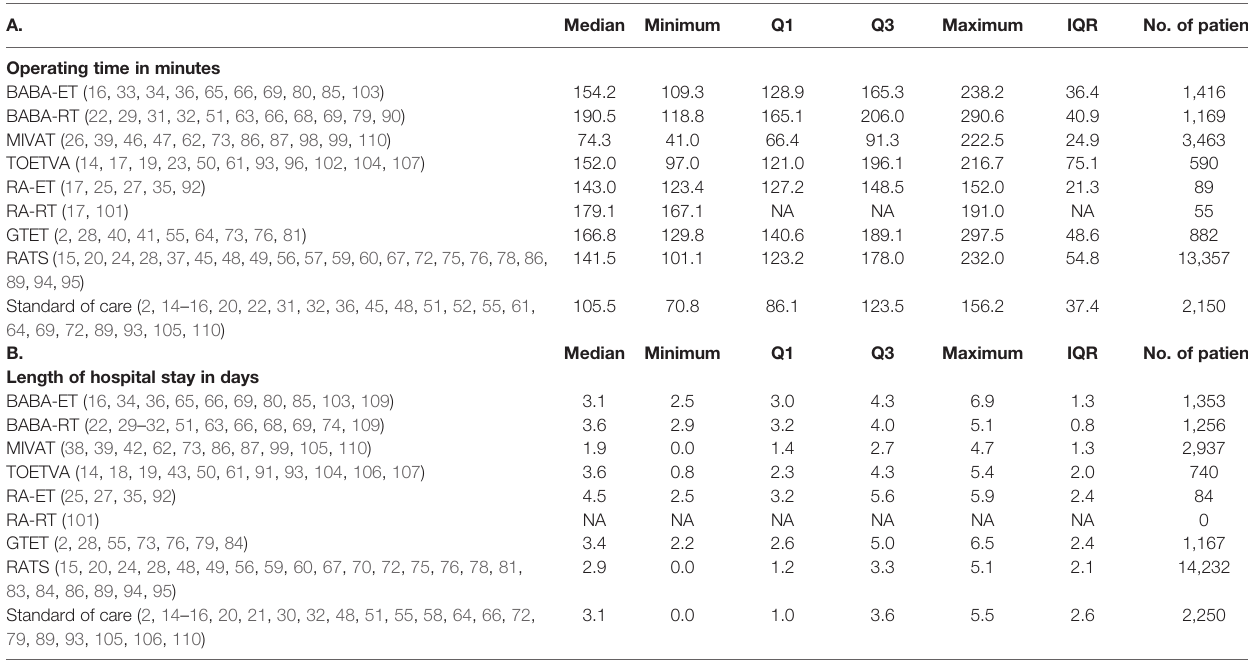
TABLE 1 | Operating time and length of hospital